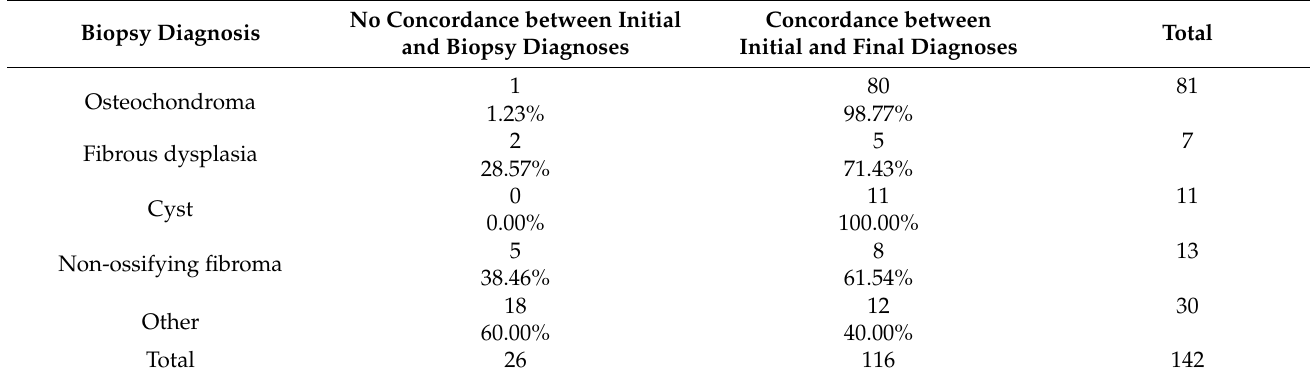
Table 2. Concordance between initial and final diagnoses.